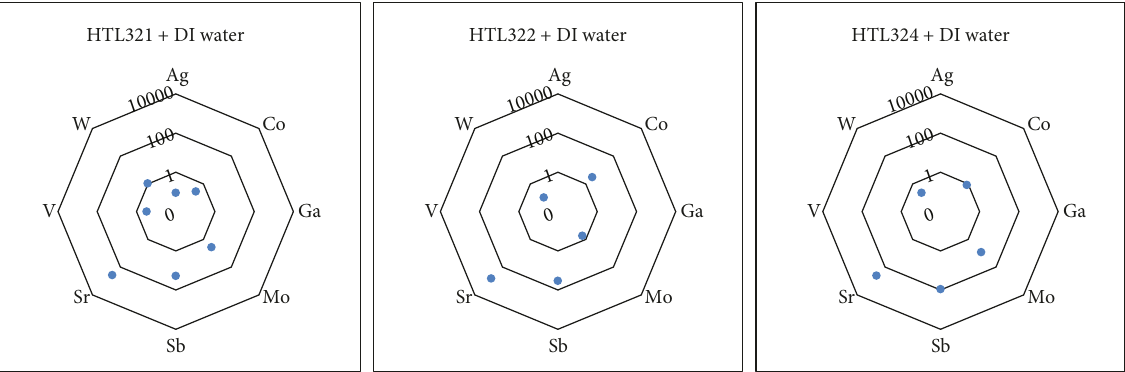
Figure 14: The amount of “ at risk ” elements in leachate from samples reacted with deionised water at 200 ° C temperature under 250bar pressure in ppb after 52 minutes, 48 minutes, and 25 minutes, respectively (absence of data points re fl ects concentrations below the limits of